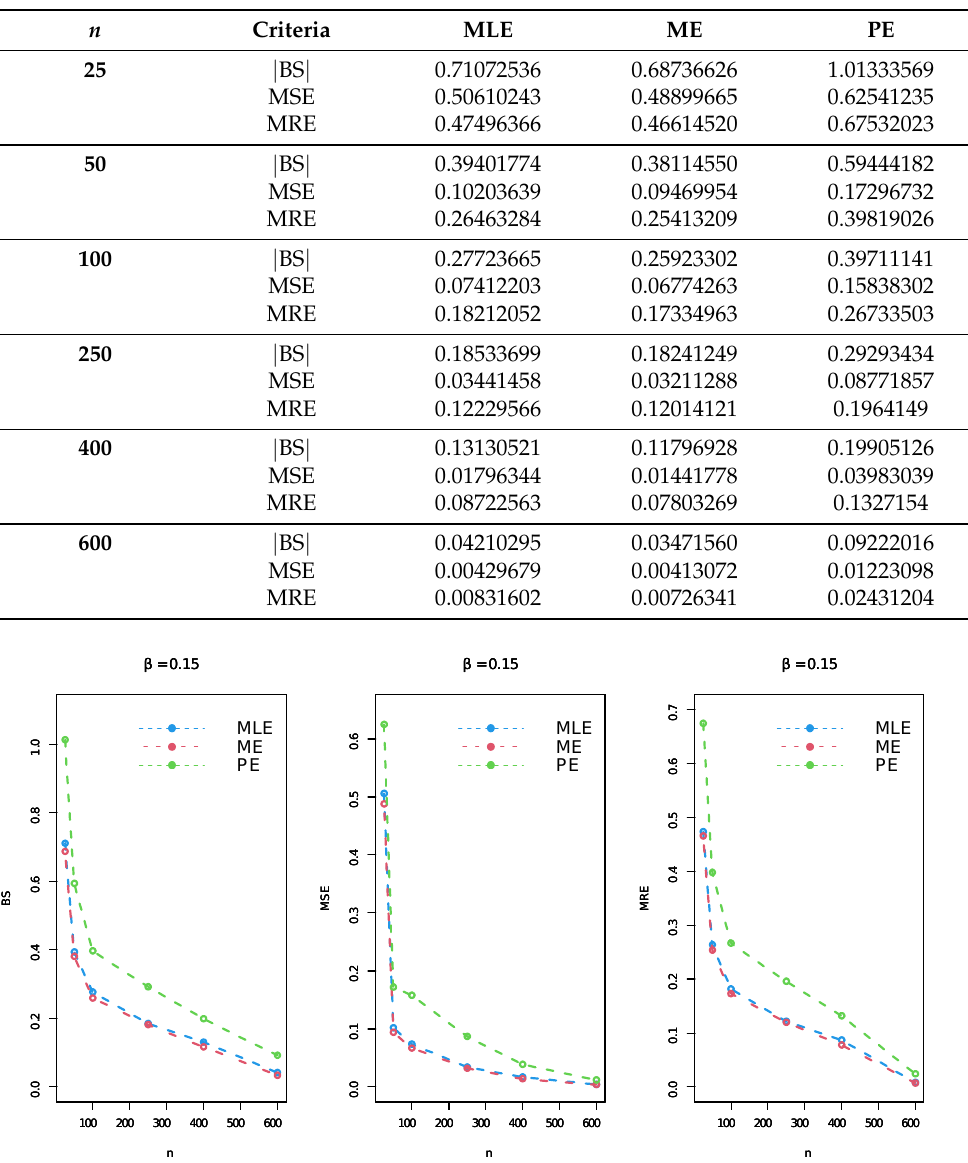
Table 3. Simulation results for (cid:12) = 0 : 15 .